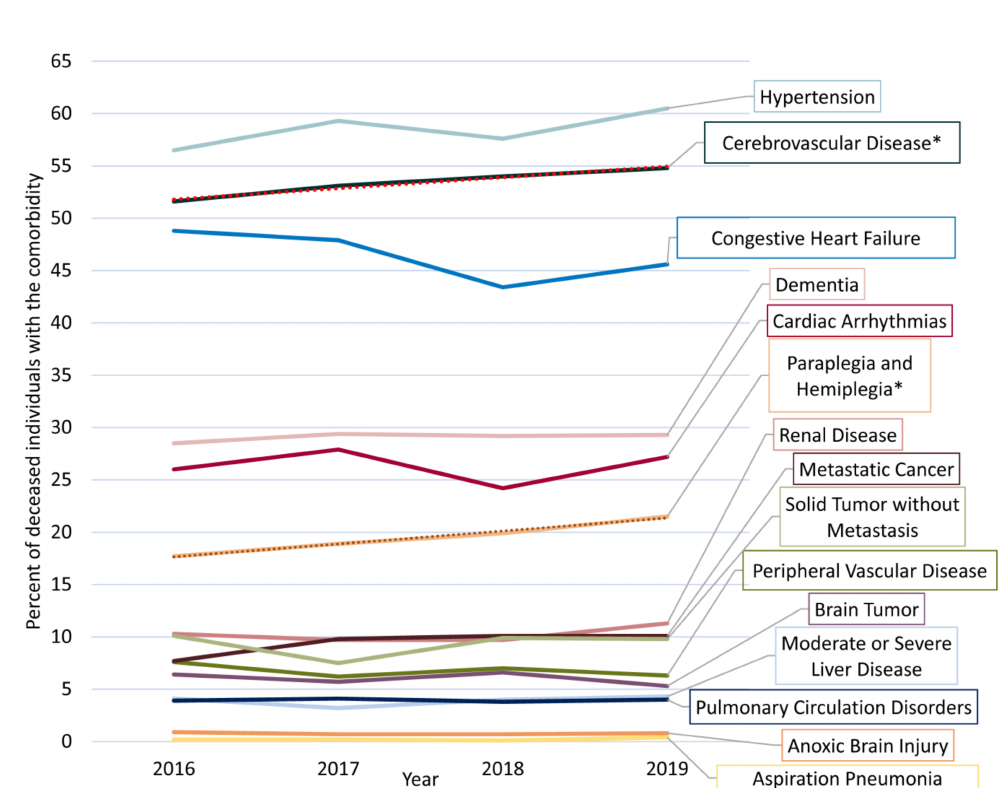
Figure 5. The prevalence of different comorbidities documented among people with epilepsy prior to their death. Conditions comprising the epilepsy-specific comorbidity index as well as cerebrovascular diseases are presented [16]. * comorbidities trending between 2016 and